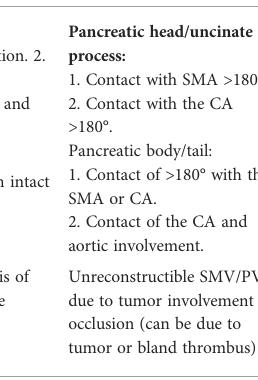
TABLE 1 De fi nition of locally advanced and borderline resectable pancreatic cancer from the NCCN-Guidelines (version 1.2021). Vessel Borderline resectable Locally advanced involvement Arterial vessels Pancreatic head/uncinate